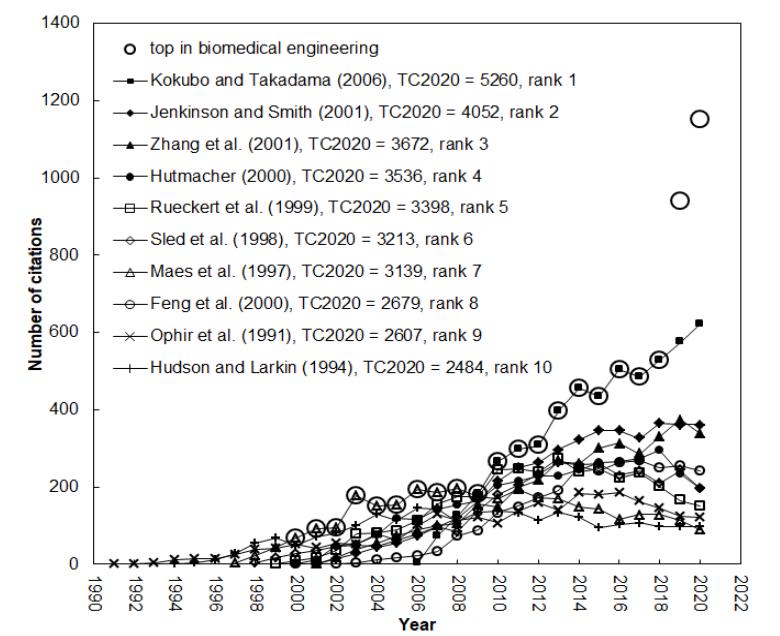
Fig. 3. Citation histories of the top 10 most frequently cited articles in the Web of Science category of biomedical engineering.